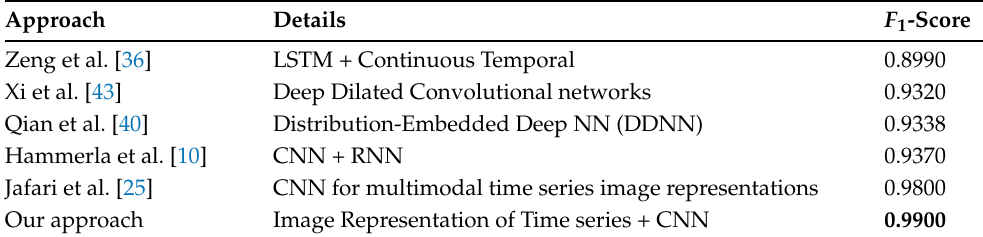
Table 5. Comparison considering PAMAP2 dataset.